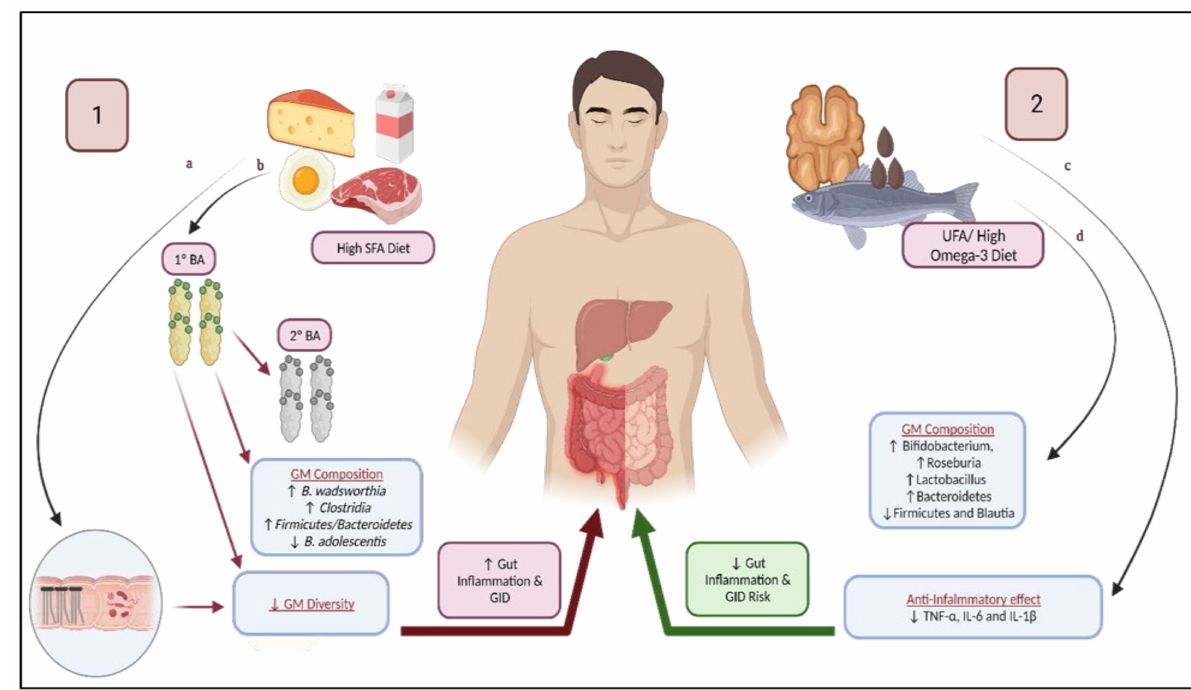
Figure 2. Dietary fat composition and risk of gastrointestinal disorders: ( 1 ) High SFA diet contributes to GID through modulation of GM. ( a ) SFA increases FA overflow to the distal intestines, reducing GM diversity, thus contributing to GID. ( b ) SFA increases the levels of primary and secondary bile acids, contributes to changes in GM composition, reduced GM diversity, and gastrointestinal inflammation, thus increasing the risk of GID. ( 2 ) Unsaturated fats, particularly high omega-3 diets, reduces GID risk due to ( c ) significant reduction of proinflammatory cytokines and ( d ) its favorable impact on GM composition and diversity, increasing SCFA levels. BA: bile acid; GM: gut microbiome; GID: gastrointestinal disorders; SFA: saturated fatty acids; SCFA: short-chain fatty